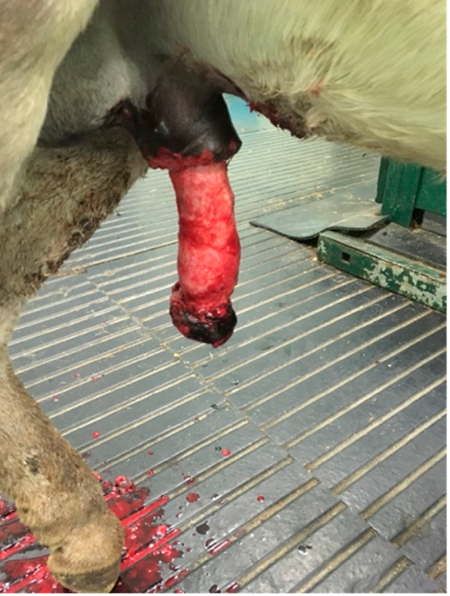
Figure 11. Failure of primary closure on the 12th day after surgical repair (clinical case 1).